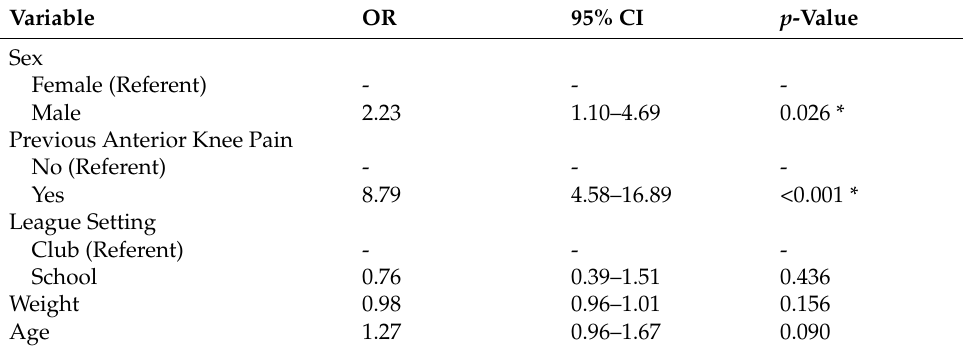
Table 2. Multivariable Logistic Regression Model for Patellar Tendinopathy in youth basketball players ( n =